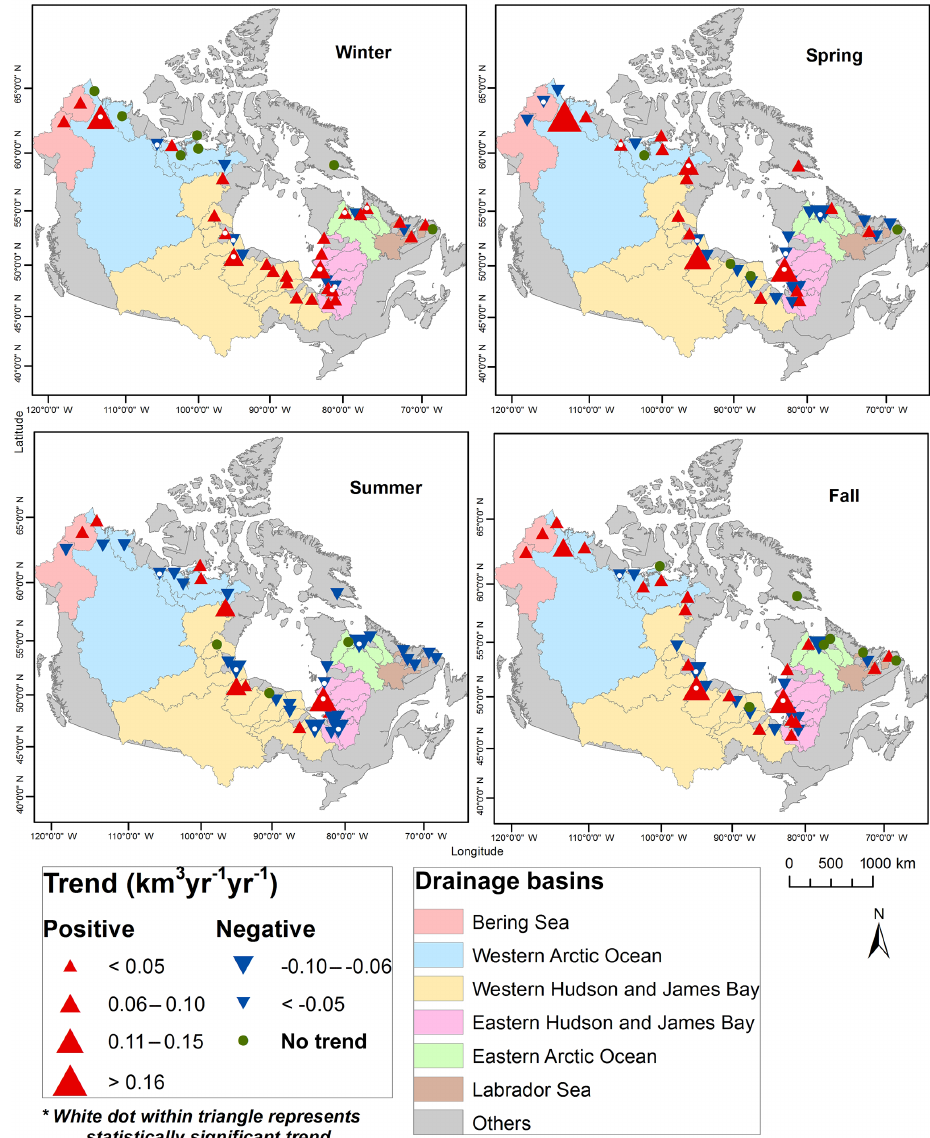
Figure 7. Spatial trend analysis for the seasonal discharge of 42 rivers of northern Canada,